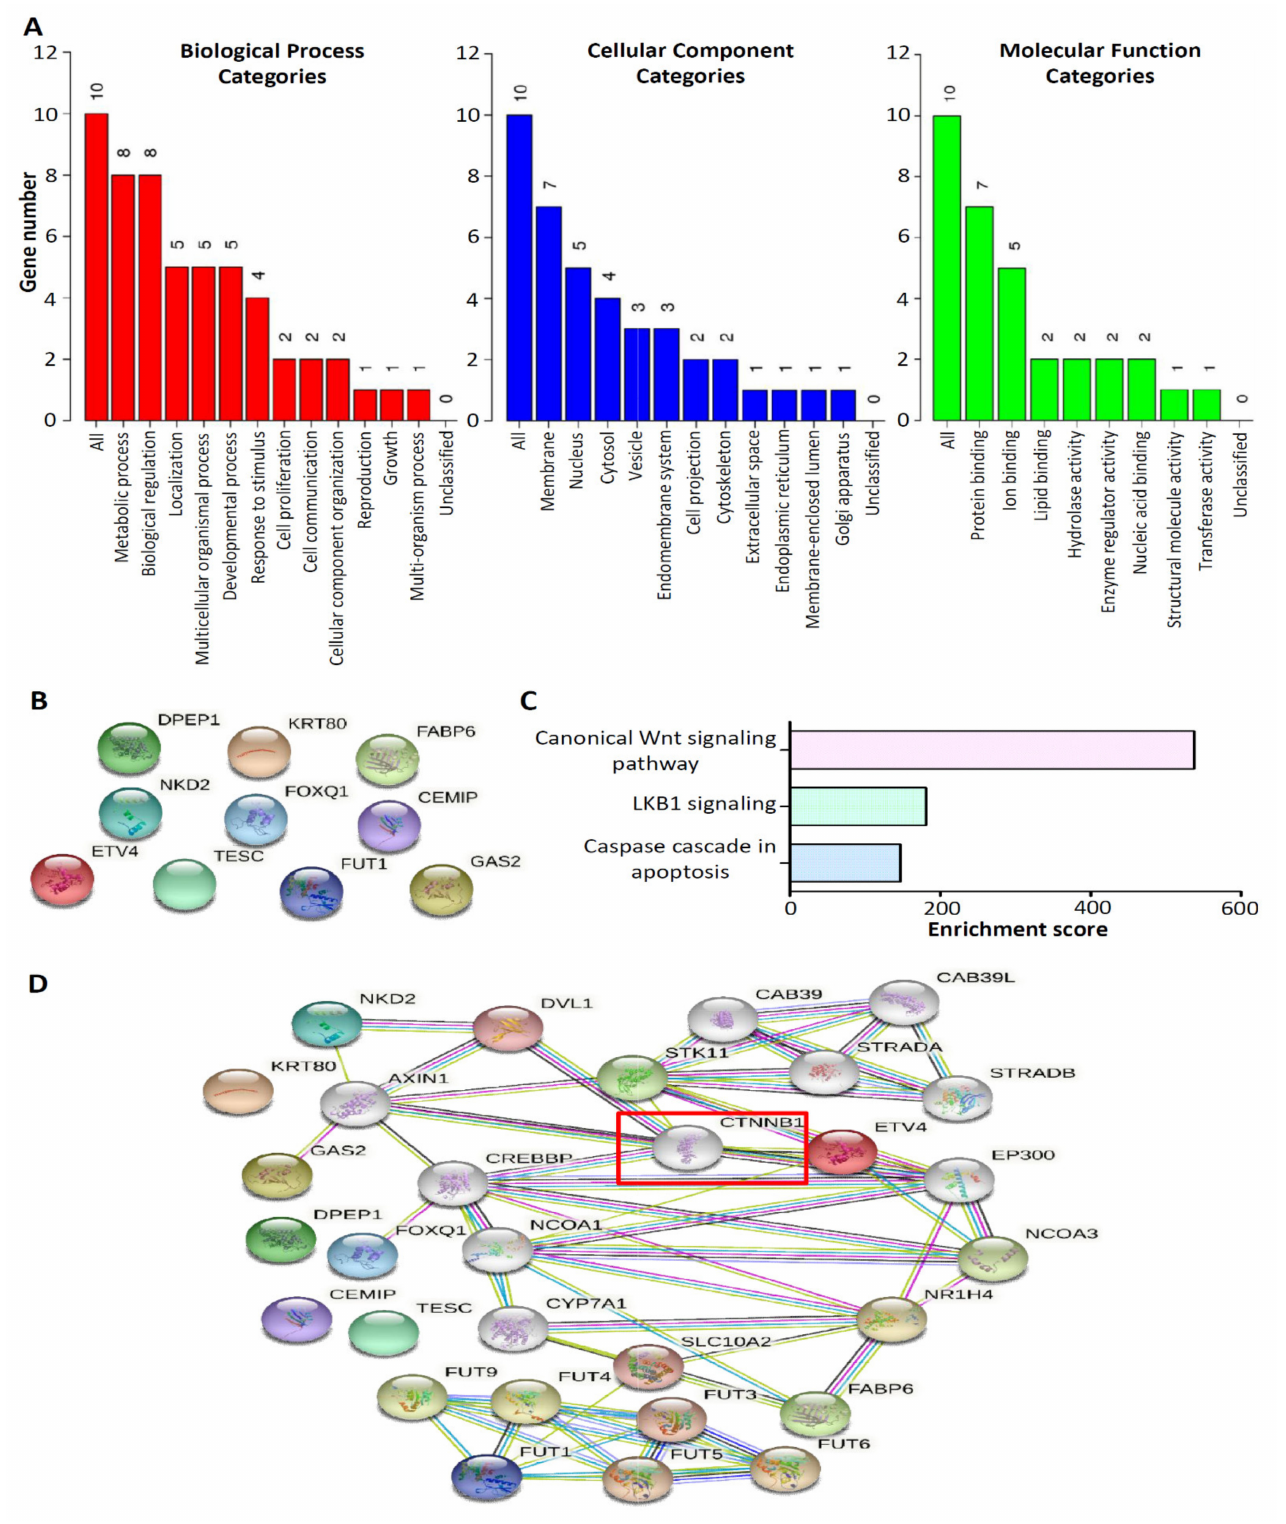
Figure 5. Gene function and pathway enrichment analysis of the top 10 upregulated CRC-associated genes. ( A ) Gene ontology analysis of the top 10 upregulated CRC-associated genes. The results are presented for the following three categories: Biological process, cellular component, and molecular function. The bar represents the number of genes in the user list. Protein–protein interaction network analysis of the top 10 upregulated CRC-associated genes ( B ), which was involved in the canonical Wnt signaling pathway to perform using the Enrichr method ( C ). ( D ) CTNNB1 was predicted as the key factor involved in the canonical Wnt signaling pathway for interaction with the 10 upregulated CRC-associated